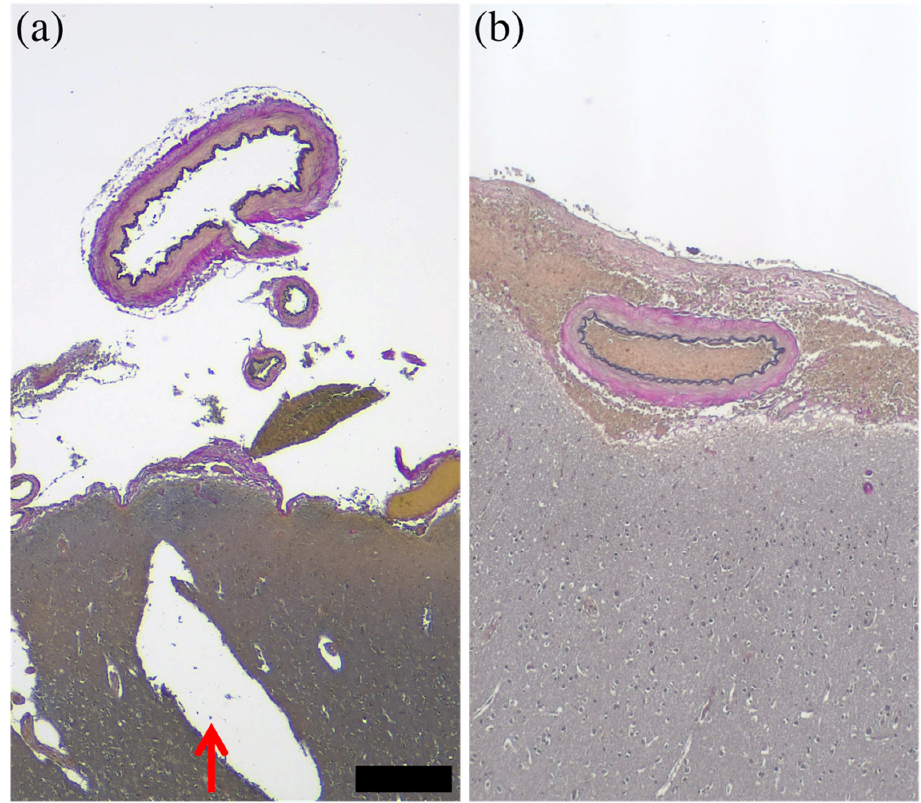
Figure 7. Comparison of histopathological images with/without CUBIC processing. Between the histopathological (Elastica van Gieson staining) images with ( a ) and without ( b ) CUBIC processing, there was little effect of CUBIC processing on the arteries, but the brain parenchyma was cracked (red arrow). This cracking was likely due to the weakening caused by CUBIC processing. The bar (on the lower right side of ( a )) is equal to 300 µ m for ( a , b